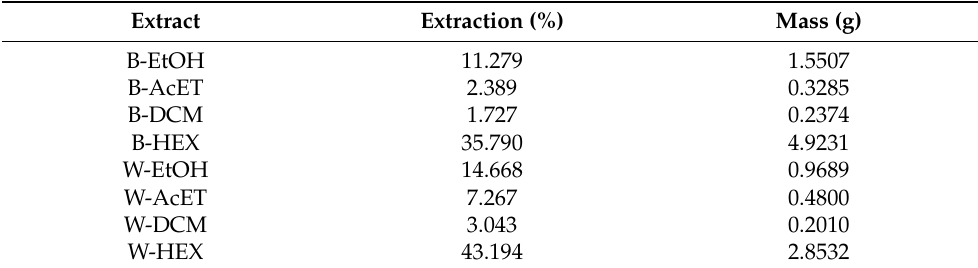
Table 1. Dry extract mass and extraction percentage for each extract obtained by successive macera- tion of chia leaves of black (B) and white (W) seed phenotype. Extract Extraction (%) Mass (g) B-EtOH 11.279 1.5507 B-AcET 2.389 0.3285 B-DCM 1.727 0.2374 B-HEX 35.790 4.9231